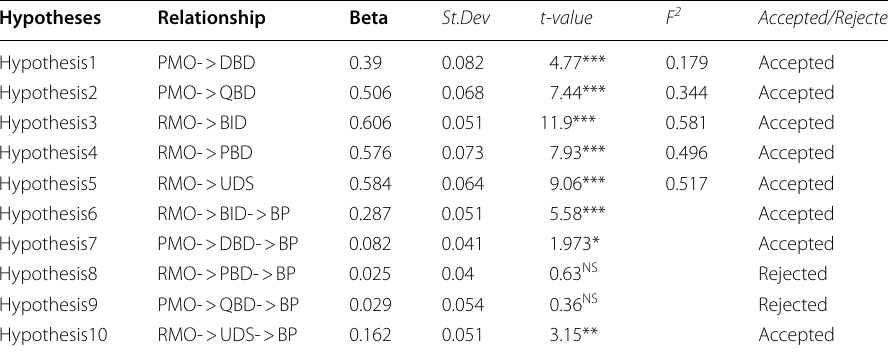
Diagonal values are the square root of average variance extracted (AVE) Table 3 Hypotheses testing